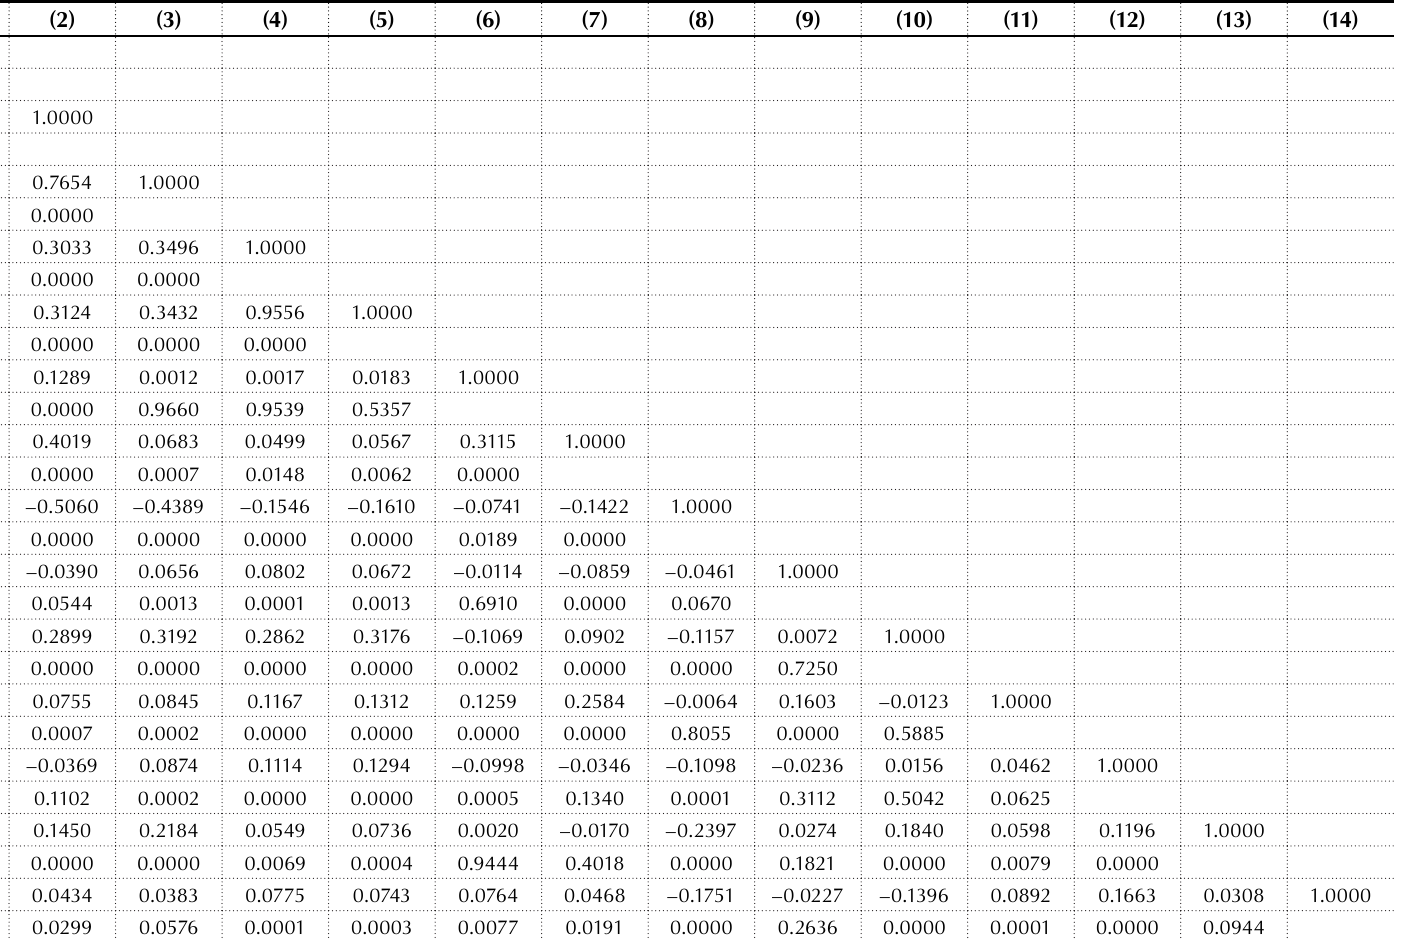
Table 5 (cont). Correlation matrix of risk and profitability regression variables Panel B: